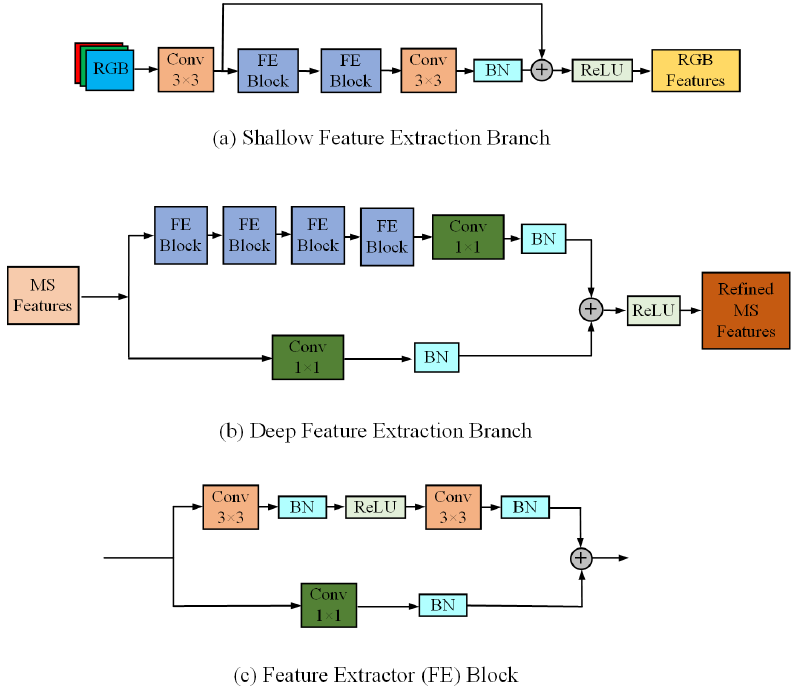
Figure 3. Structure of the feature extraction branches, where ( a – c ) represent shallow feature extraction branch, deep feature extraction branch and feature extractor block,